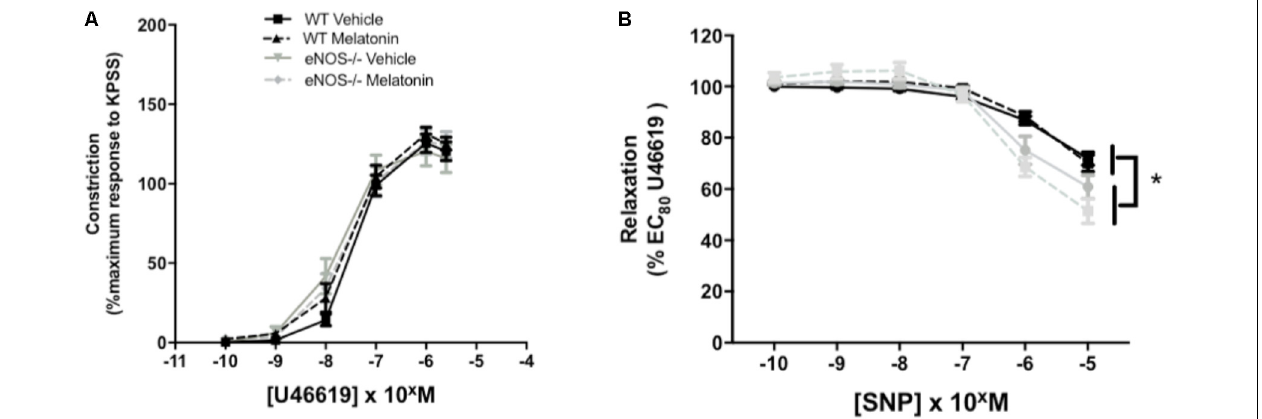
FIGURE 4 | Constriction and relaxation responses of umbilical arteries from WT and eNOS - / - mice at embryonic day 18.5. (A) Dose-dependent constriction to 10 - 10 to 2 × 10 - 6 M U46619 shown as a percentage of the maximum constriction to KPSS. (B) Dose dependent relaxation to sodium nitroprusside (SNP) is shown as a percentage of EC 80 U46619 constriction. Data are presented as mean ± SEM. N’s as follows ( N = litters, n = pups); WT vehicle N = 5, n = 20, WT melatonin N = 5, n = 17 eNOS - / - vehicle N = 5, n = 12, eNOS - / - melatonin N = 5, n = 17. Statistical analysis was carried out by two-way ANOVA to assess the effect of genotype and treatment with Bonferroni post-test to compare individual groups. ∗ P < 0.05 WT vs. eNOS - / - .